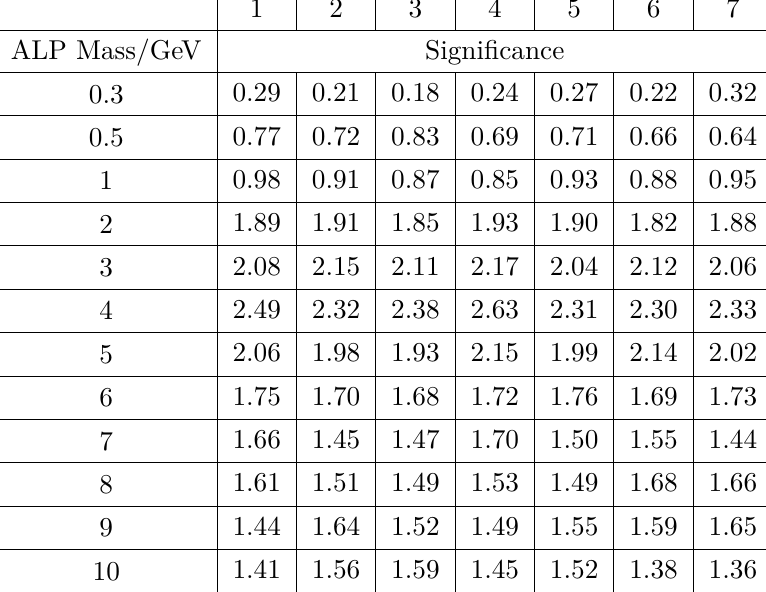
Table 5 . The optimal significance for the ALP-strahlung production process pp → Za obtained from the trainings of seven significance neural networks. The benchmark point is chosen as g 0 . 64 TeV − 1